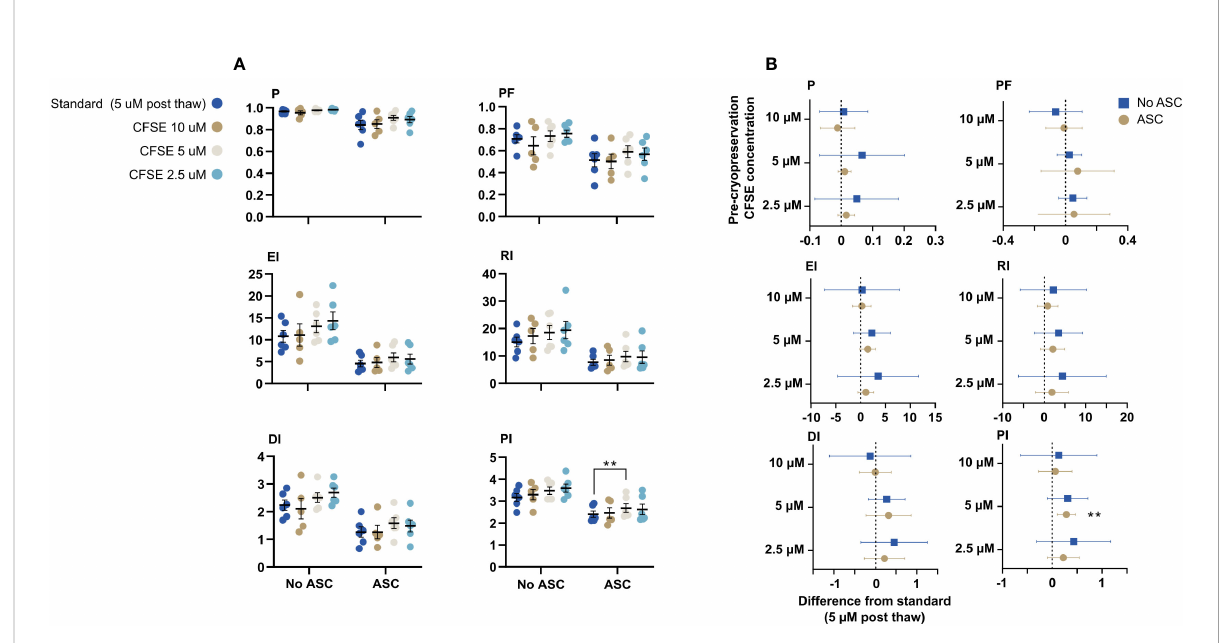
FIGURE 8 CFSE-labelling prior to cryopreservation. PBMC were labelled with CFSE at 3 different concentrations: 2.5, 5, and 10 µM prior to cryopreservation or with 5 µM after thawing (standard). (A) The impact on the six proliferative metrics (P, EI, DI, PF, RI and PI) for T cells when the PBMC were labelled prior to cryopreservation compared to standard. The cells were stimulated with PHA in presence or absence of ASC. (B) Mean difference from standard (dotted line) with con fi dence intervals. Mixed-effects model with Dunnett ’ s test for multiple comparisons and 95% con fi dence interval. n= 6, except for 10 µM CFSE (n=5). CFSE, Carboxy fl uorescein succinimidyl ester; ASC, Adipose tissue-derived stromal cells; PBMC, Peripheral Blood Mononuclear Cells; PHA, Phytohemagglutinin; P, Fraction diluted/Proliferating cells; EI, Expansion Index; DI, Division Index; PF, Precursor Frequency; RI, Replication Index; PI, Proliferation